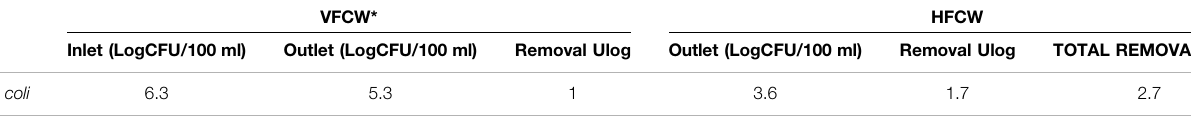
TABLE 4 | E. coli concentration (Log CFU/100 ml) and removal (Ulog) (n (cid:2) 78).